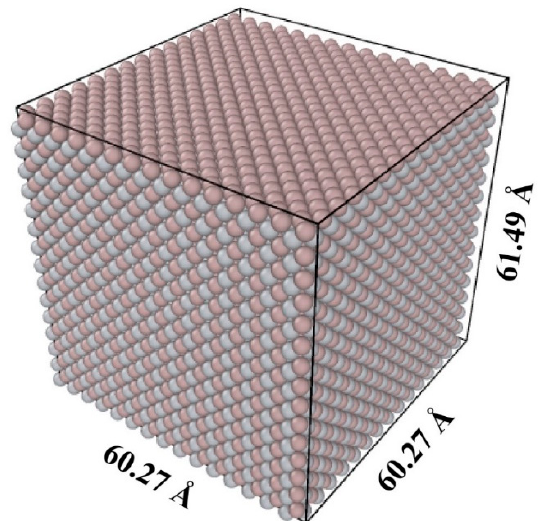
Figure 1. Initial configuration of TiAl alloy. Gray and pink balls represent Ti and Al atoms, respectively.